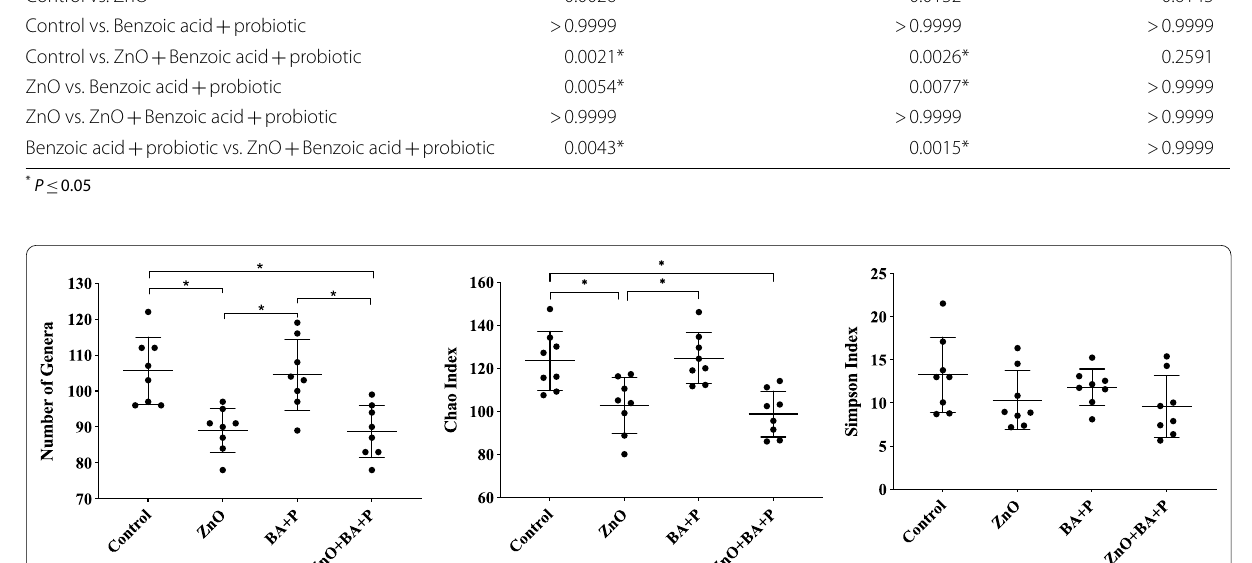
Fig. 2 Alpha diversity indices. Number of observed OTUs ( A ), Chao index ( B ) and Simpson’s index ( C ) observed in the cecum of piglets post-weaning supplemented with Zinc Oxide (ZnO), Benzoic acid plus probiotic (BA